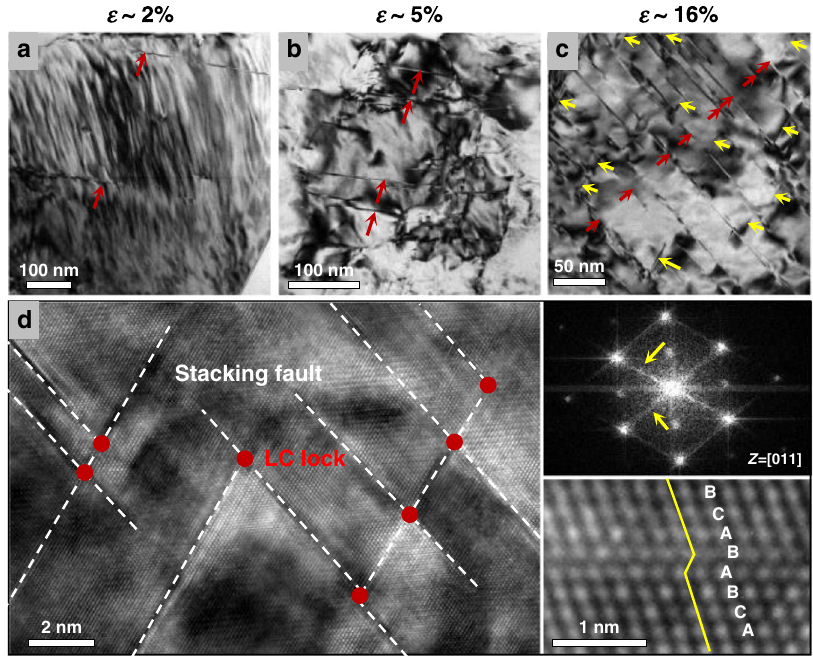
Fig. 3 Plastic deformation micro-mechanisms of the CNL alloy. a Deformation microstructure at the 2% strain revealing the activation of parallel SFs (red arrow). b Activations of more planar SFs (red arrow) at the 5% strain. c High-density hierarchical SFs on two {111} slip planes (red and yellow arrows) at the 16% strain. d High-resolution TEM image showing the hierarchical SF network (white dash line) and Lomer-Cottrell (LC) locks (red dot) in different intersecting {111} slip systems. The FFT image with crossing diffraction fringes (yellow arrow) reveals the presence of intersected SFs, and an enlarged view of a representative SF is marked by the BCABABCA-stacking